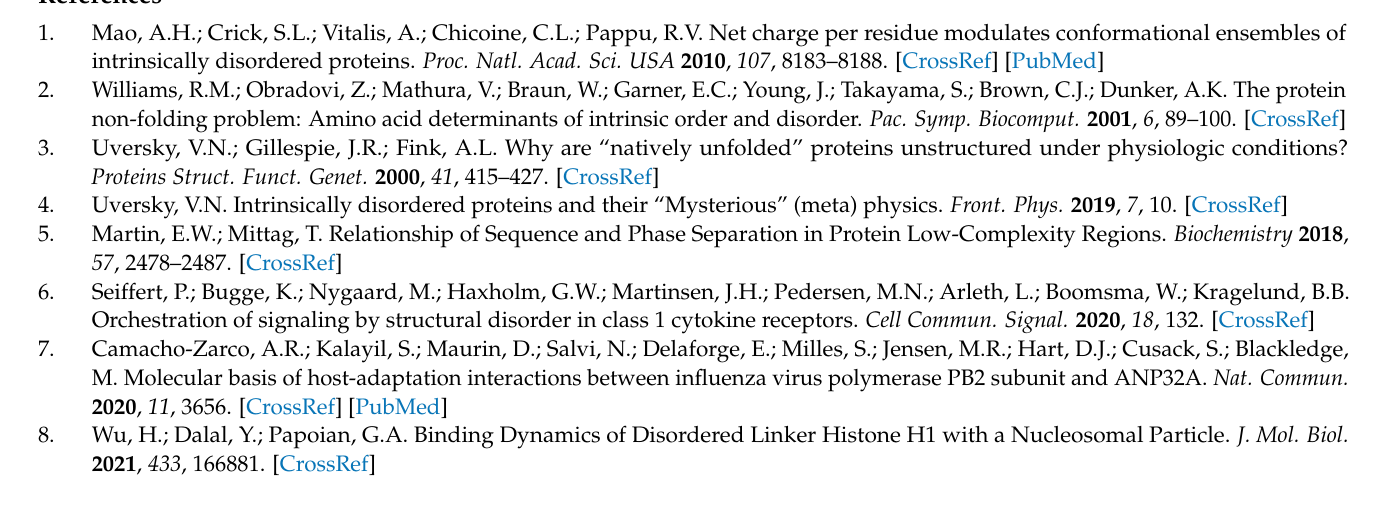
methodology; Figure S1: ANAC046 172-338 secondary chemical shifts; Figure S2: Amide HSQCs for proteins in the presence and absence of calcium chloride; Figure S3: Scatchard plots for proteins and SM1-4 peptides, measured via OCPC assay; Figure S4: SM1-4 peptide TOCSY, ROESY, and amide HSQC spectra with assignments in the presence and absence of calcium